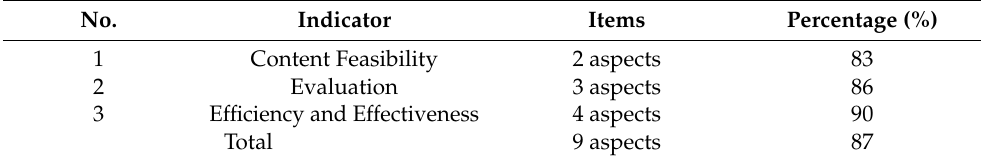
Table 2. Results of Subject-Matter-Expert